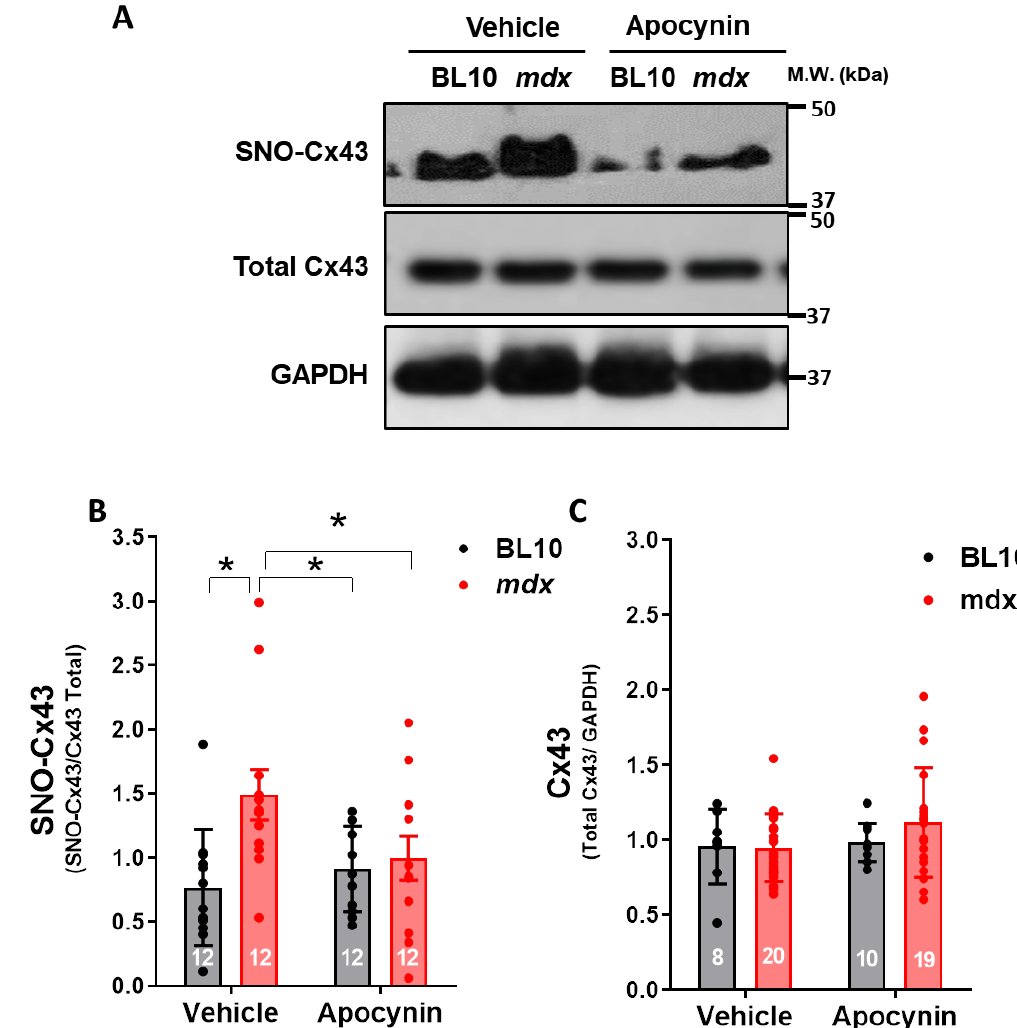
Figure 7. S-nitrosylation of Cx43 is inhibited by NADPH oxidase blockade. ( A ) Representative Western blots for the total and S-nitrosylated (assessed by the biotin-switch technique) levels of Cx43 (SNO-Cx43) in cardiac homogenates from 10-month-old wild type (BL10) and mdx mice, treated with the vehicle or apocynin. All hearts were previously submitted to stimulation with isoproterenol. M.W., molecular weight standards, KDa, kilodaltons. ( B ) Graphs depicting the quantification of Cx43 S-nitrosylation. ( C ) Quantification of the total Cx43 normalized by the levels of GAPDH. *, p < 0.05 for the comparisons indicated by brackets, ANOVA followed by Newman–Keuls as post-hoc test. The n is indicated inside each bar of the graphs.